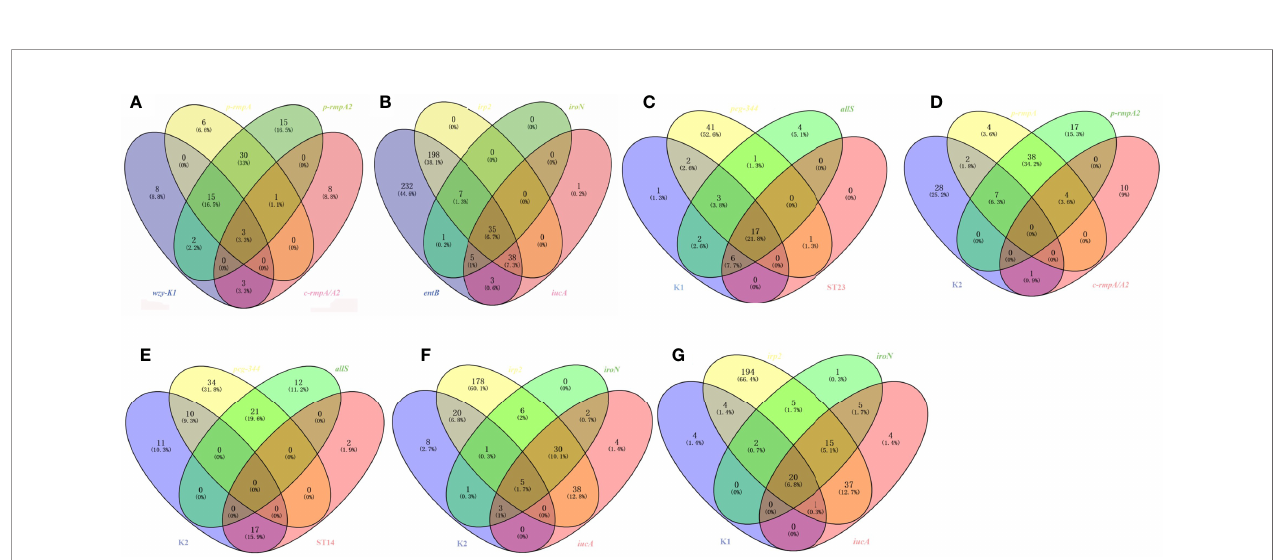
FIGURE 2 | Modes of virulence genes in 521 K. pneumoniae strains. The presence of virulence genes is represented by a dark blue box and the absence of others is represented by a light blue box. Only those with ≥ 2 strains were included in Figure 2 .